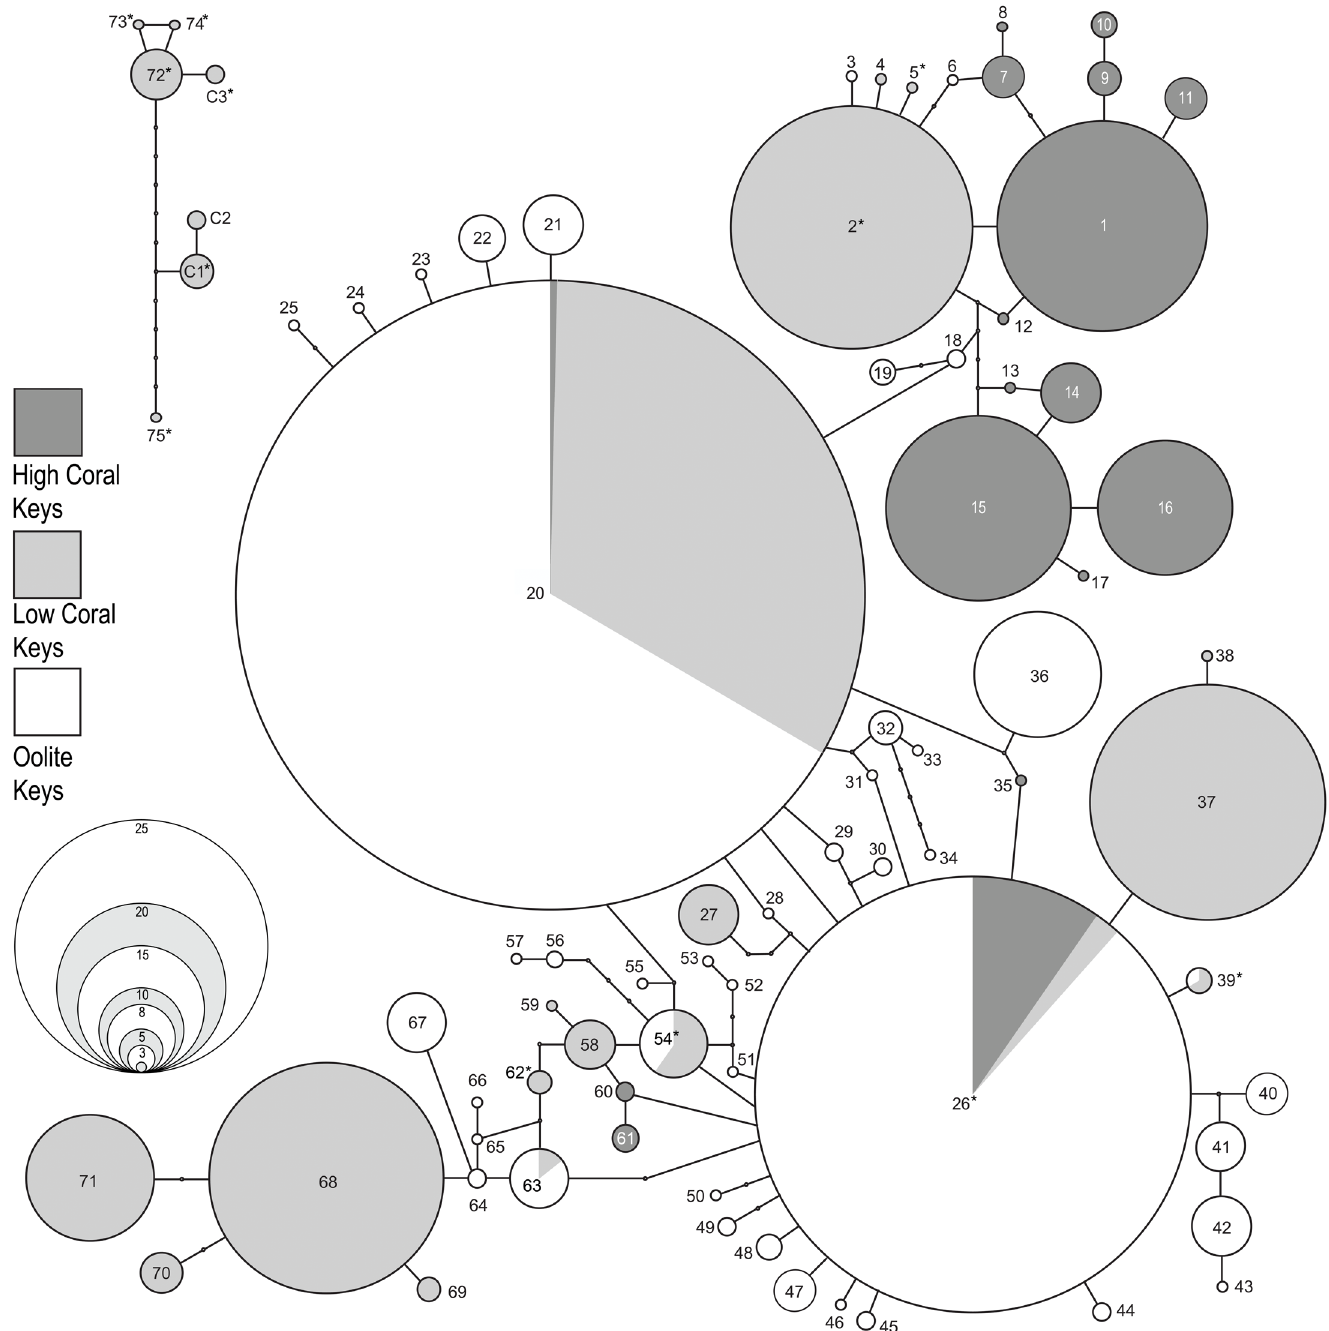
Fig 7. TCS network based on 16S haplotypes of Cerion of the Florida Keys. Haplotypes are sequentially numbered. In instances where identical haplotypes occur in more than one region, circles are proportionally shaded. * denotes haplotypes present in the BHSE population that includes C . incanum x C . casablancae hybrids. (See Appendix 1 for correlation of network haplotype numbers with individuals and populations as they appear in the Bayesian analysis.)